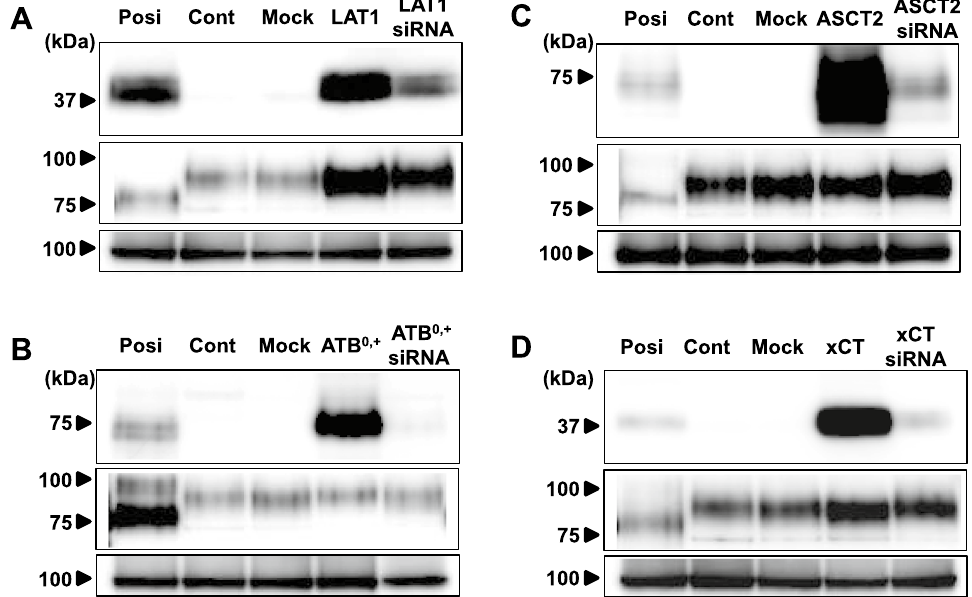
Fig. 2 Overexpression of human amino acid transporters. Western blot analyses were performed using anti-human A LAT1, B ATB 0, + , C ASCT2, and D xCT antibodies on membrane protein extracts from the positive-control cells, negative-control cells (CHO-K1 cells), control vector-transfected cells (Mock), expression vector-transfected cells, and gene-specific siRNA-transfected cells (upper panel). The positive-control cells were A MCF-7, B T3M-4, C NCI-H460, and D A549 cells. The same blots were also probed with anti-CD98 antibody (middle panel), and anti-Na antibody as a loading control (lower